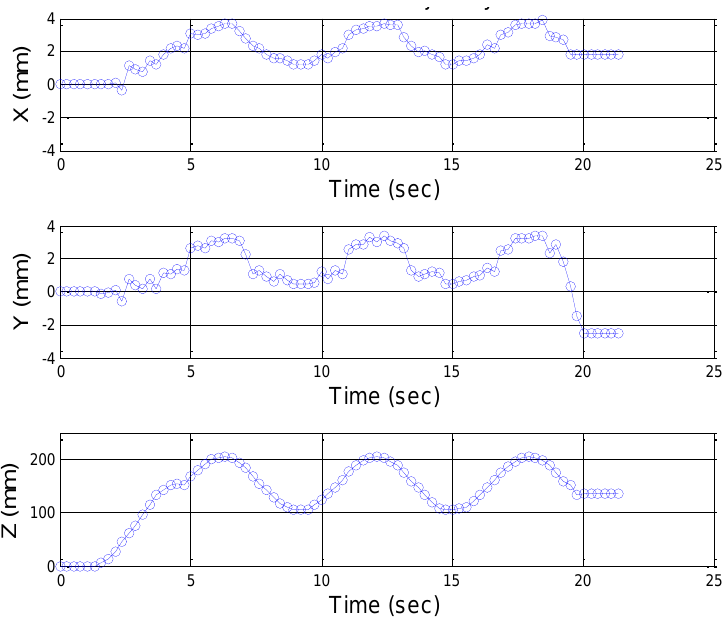
Figure 18. Stereo vision measuring results of sinusoidal